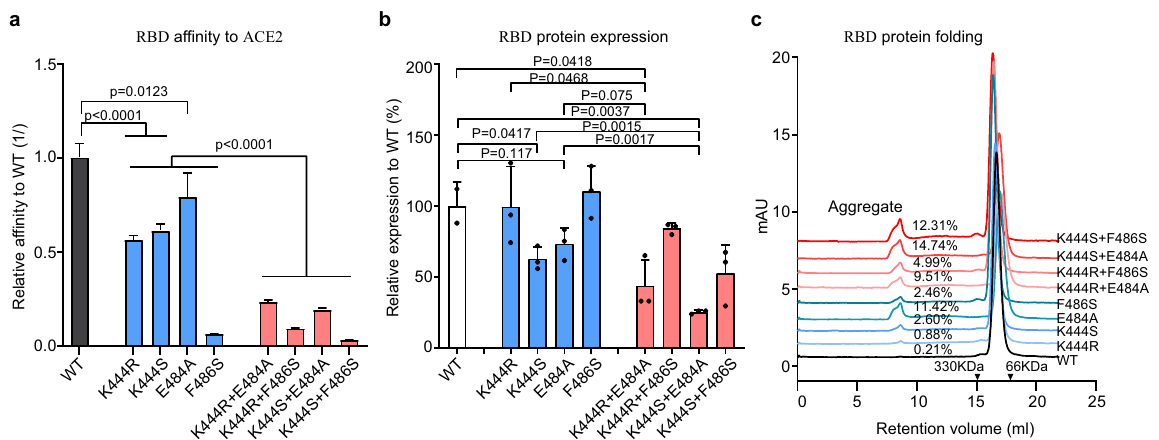
Fig. 6 Effects of single-site or double-site mutations on the RBD af fi nity to ACE2, the expression level, and the folding stability of RBD. a The relative binding af fi nities of the sCoV2-RBD mutant proteins ACE2. The y -axis indicates the reversed value of K D of mutants/WT. Data are mean ± SD of the K D values from fi tting of fi ve kinetic curves. Two-tailed Student ’ s t -test. The distribution of data points is not available from the Octet Data Analysis software. b The relative expressing levels of the sCoV2-RBD mutant proteins to wild-type (WT) protein. The y -axis indicates the value of protein concentration of mutants/WT. Data are mean ± SD of triplicate wells of transfection. Two-tailed Student ’ s t -test. c The size-exclusion chromatography (SEC) analysis of puri fi ed sCoV2-RBD mutant or wild-type proteins. The retention volume of proteins with indicated molecular weight are shown by arrowheads. The percentages of protein aggregates are shown.